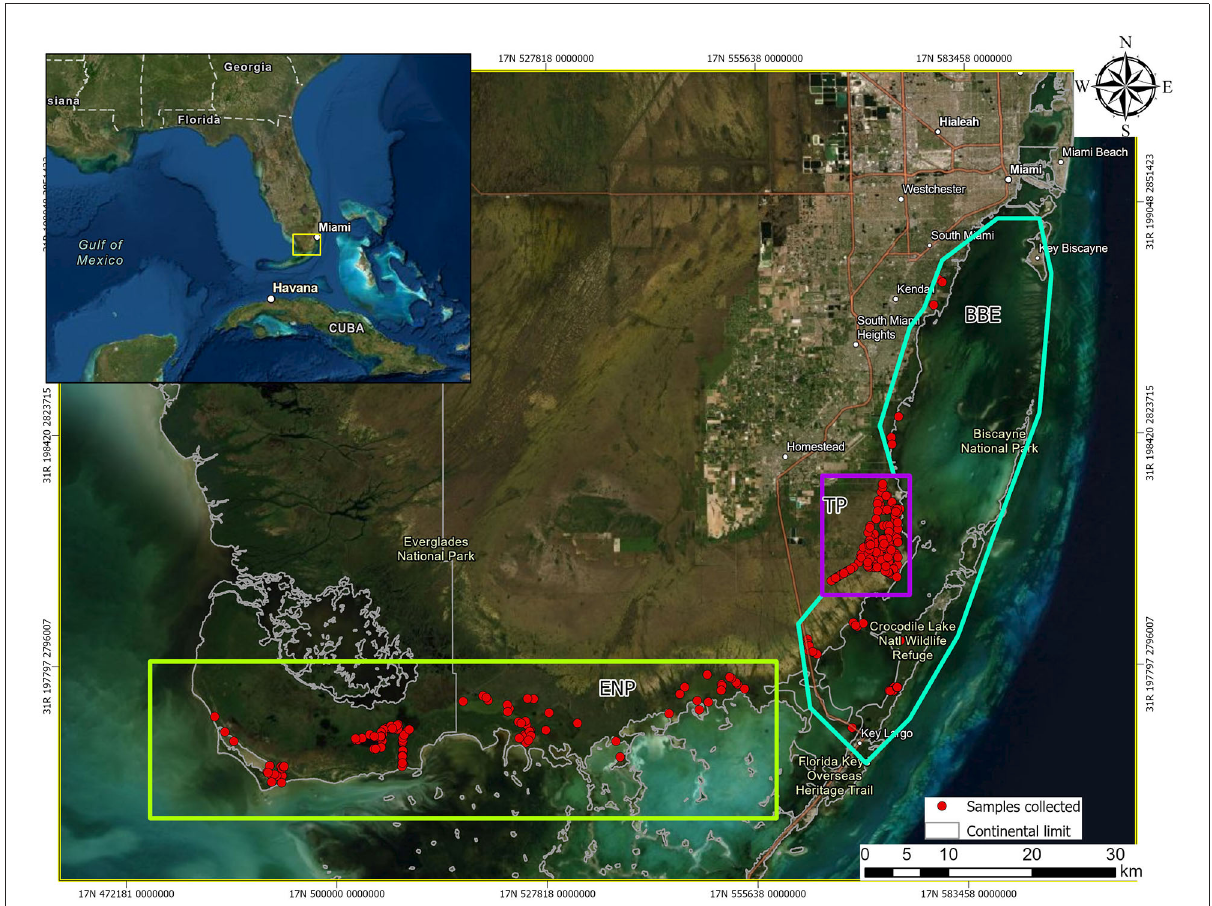
FIGURE1 Geographic location of American crocodiles ( Crocodylus acutus ) captured and drawn blood samples from across South Florida, United States, between 2015 and 2021. Notice the three areas with different human influence level, Everglades National Park (ENP, low influence, green rectangle), Biscayne Bay Estuary (BBE, medium influence, blue–green polygon), and Turkey Point Power Plant (TP, high influence, purple